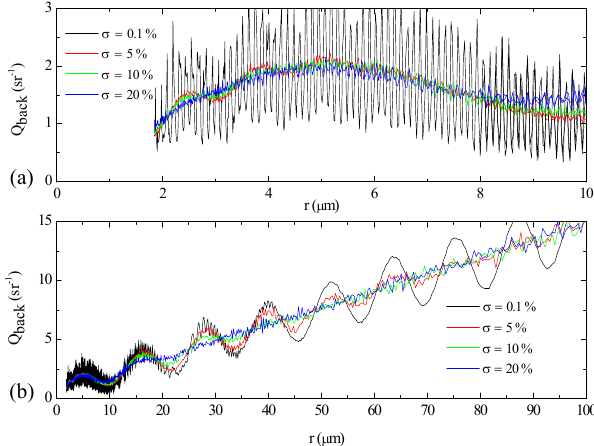
Figure 8. Simulations of the backscattering efficiency at 1064nm as a function of particle radius for lignite particles, considering a log-normal size distribution with values of σ equal to 0.1, 5, 10 and 20%. (a) Selection of a minimum radius of 1.84µm, as given by Civiš and Hovorka (2010) and a maximum radius of 10µm; (b) se- lection of a minimum radius of 8µm, as given by Triantafyllou et al. (2006) and a maximum radius of 100µm. Both simulations con- sider a sounding wavelength of